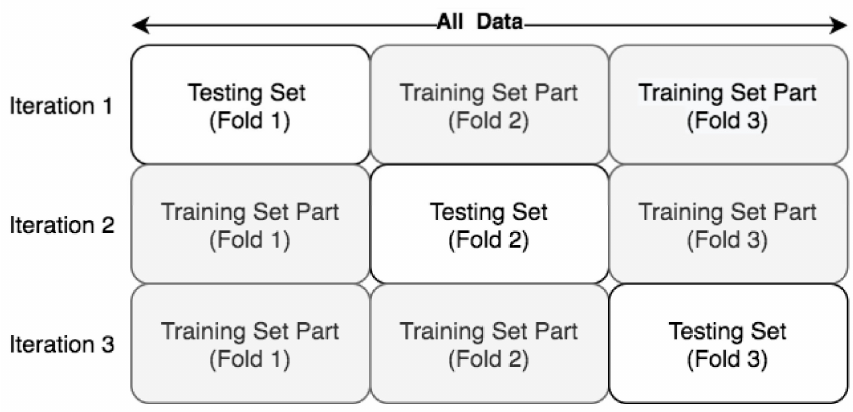
Figure 9. Illustration K = 3 cross validation set-up.